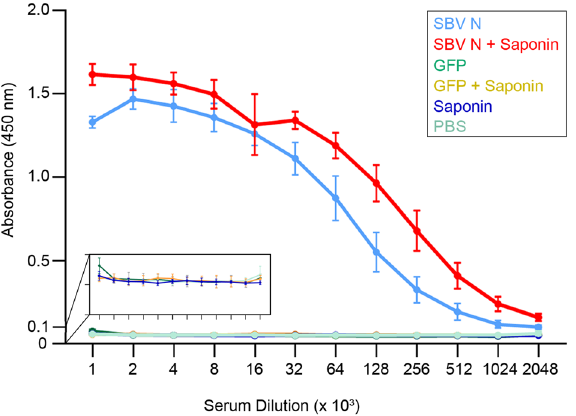
Figure 1. ELISA of sera taken from IFNAR -/- A129 mice following two vaccinations. Sera from all individual mice were tested, starting at a dilution of 1:1 × 10 3 , and assayed to a dilution of 1:2048 × 10 3 . Each point indicates the mean value of each group at 450 nm, as detected using TMB substrate. The one-sided error bars at each point represent the standard deviation. Each of the diluition shows statistical significance as determined using a one-way ANOVA